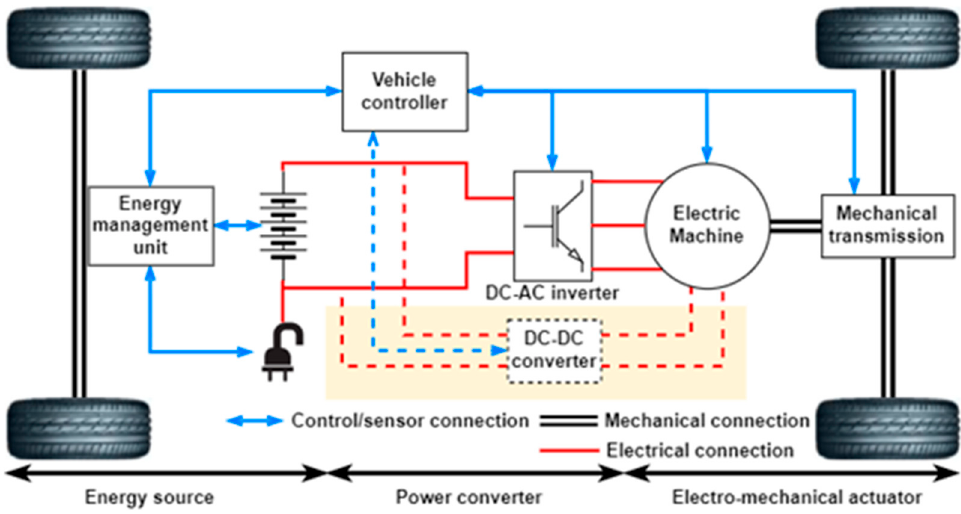
Figure 1. Scheme of an EV powertrain architecture.